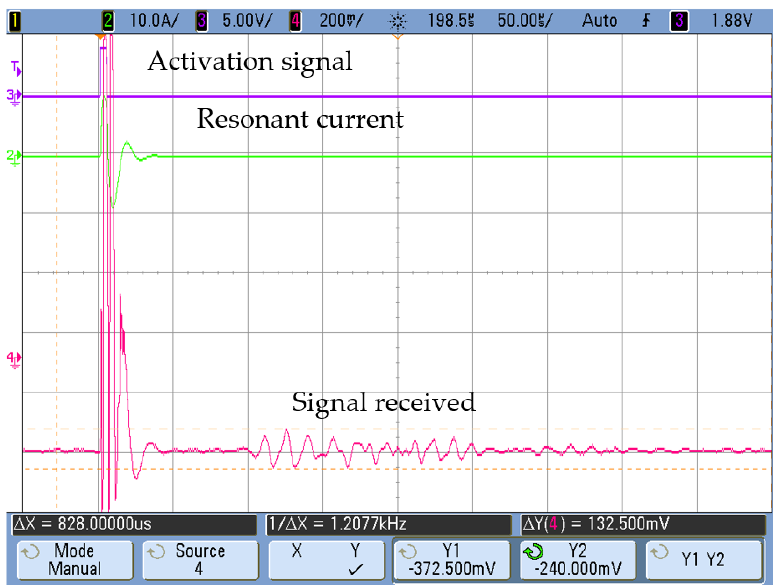
Figure 16. Signal received with a total silicone blockage (Figure 13a) at position B.